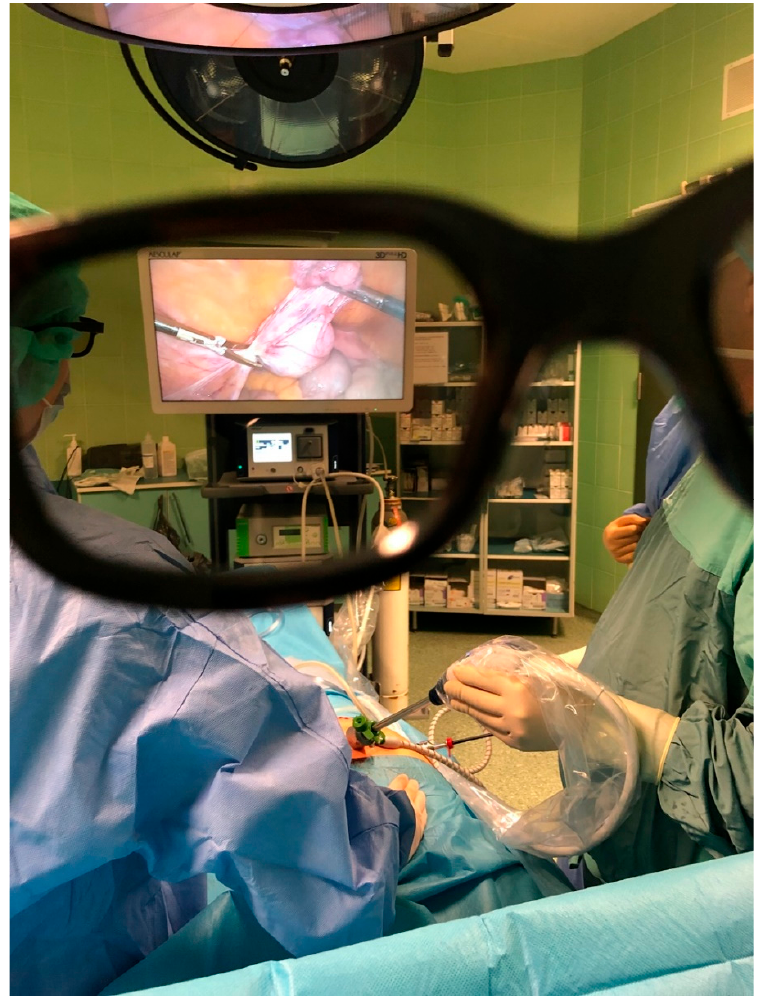
Figure 2. Final 3D image seen by the surgeon during